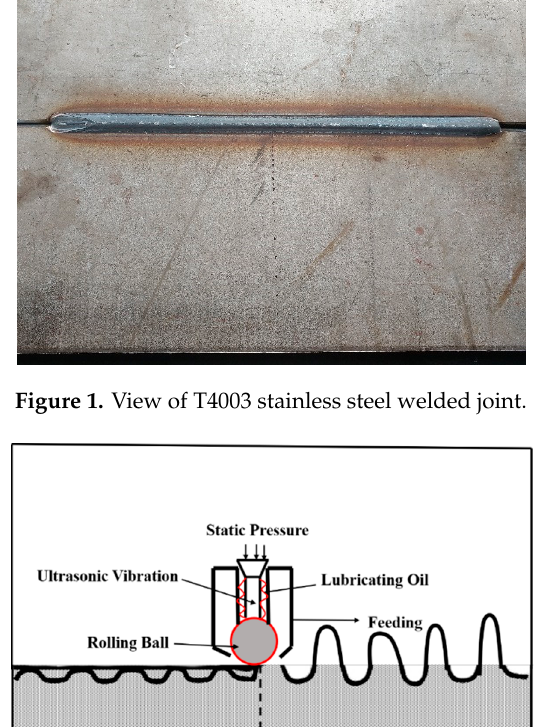
Figure 2. Schematic diagram of surface ultrasonic rolling machine.